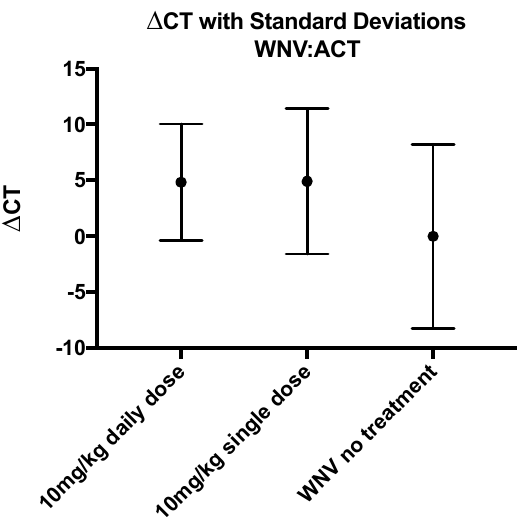
Figure 7. WNV amplification from whole blood at 7 DPI. Levels of WNV RNA were determined and normalized to ACT to calculate the ∆ CT for each treatment group. No significant differences in the levels of WNV RNA were found between each treatment group when compared using a One-Way ANOVA.